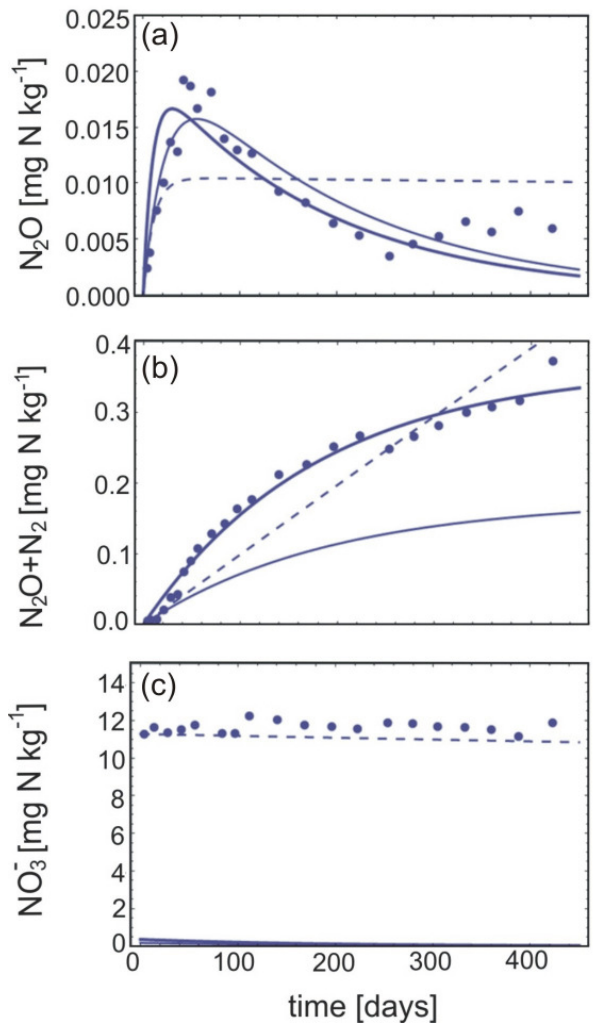
Figure 4: Comparison between experimental N 2 O- (a) , (N 2 O+N 2 ) - (b) , and NO − (c) concentrations (solid circles) and fitting curves (thick solid line: sequential 3-parameter fit; thin solid line: 1-step 3-parameter fit; dashed line: sequential 2-parameter fit) for the data set I1-S2 2.0–2.5 (heterotrophic denitrification). The rate constants k 1 and k 2 as well as the initial nitrate concentration C 0 were used as fitting parameters for the 3-parameter fits.